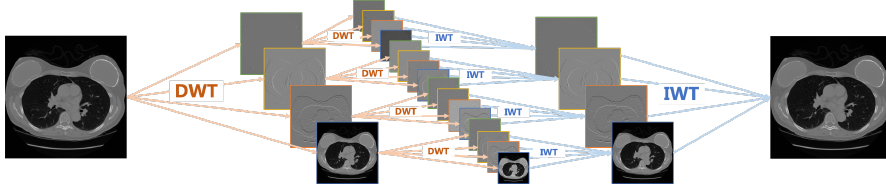
Figure 2. Multi-level WPT